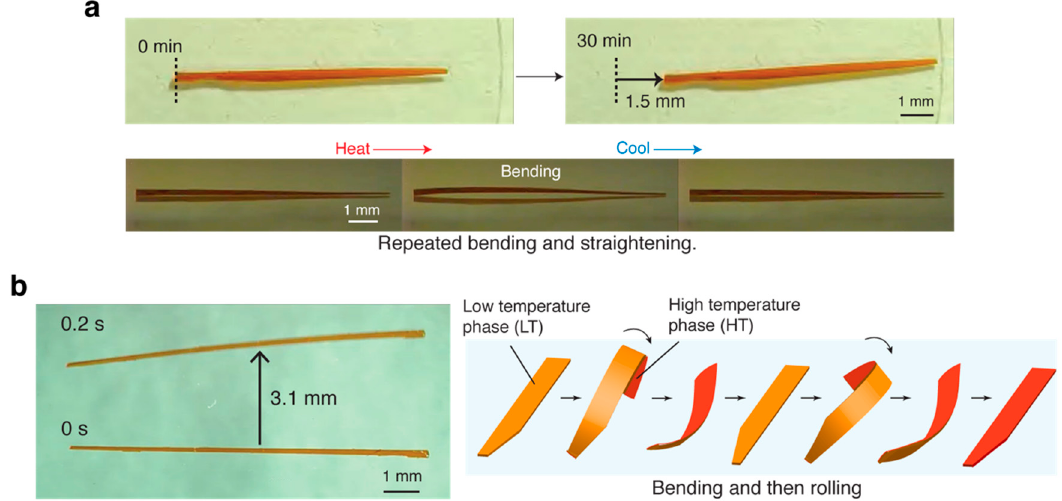
Figure 9. Thermal locomotion of crystals of trans -( S )- 11 due to the structural phase transition. ( a ) Inchworm-like “walking” of a crystal with a thickness gradient along the length under cycles of heating and cooling. ( b ) Rolling of a thin crystal with a width gradient upon heating or cooling. Reprinted with permission from [50]. Copyright 2018 Springer Nature.